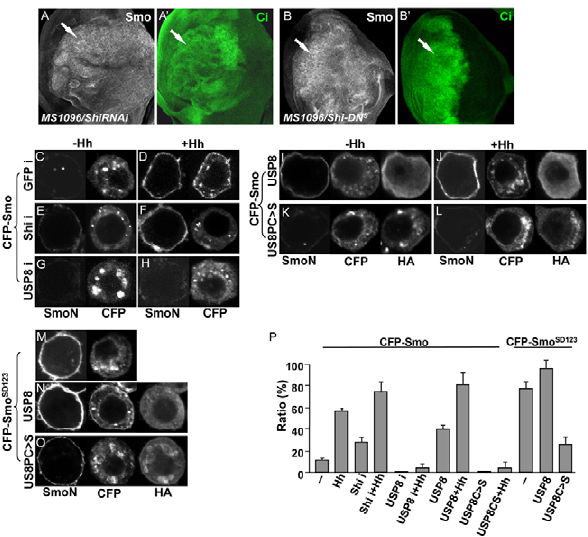
Figure 10. USP8 is required for Hh-induced Smo cell surface accumulation. (A–B 9 ) Wing discs expressing UAS-ShiRNAi or UAS- Shi- DN S (a strong line) by MS1096 Gal4 was stained for Smo and Ci. The arrows indicate the RNAi-mediated increase in accumulation of Smo and Ci. (C–O) CFP-Smo or CFP-Smo SD123 was transfected into S2 cells and the cells were treated with GFP dsRNA, Shi dsRNA, USP8 dsRNA, or Hh-conditioned medium. Smo that localized to the cell surface was visualized by immunostaining with an anti-SmoN antibody before membrane permeabilization. The total amount of expressed Smo was indicated by the CFP signal. Representative images are shown here. (P) Quantification analysis of the percentage of Smo on the cell surface (mean 6 s.d.; n $ 15). Ratio (%)=(cell surface signal/whole cell signal) 6 100.